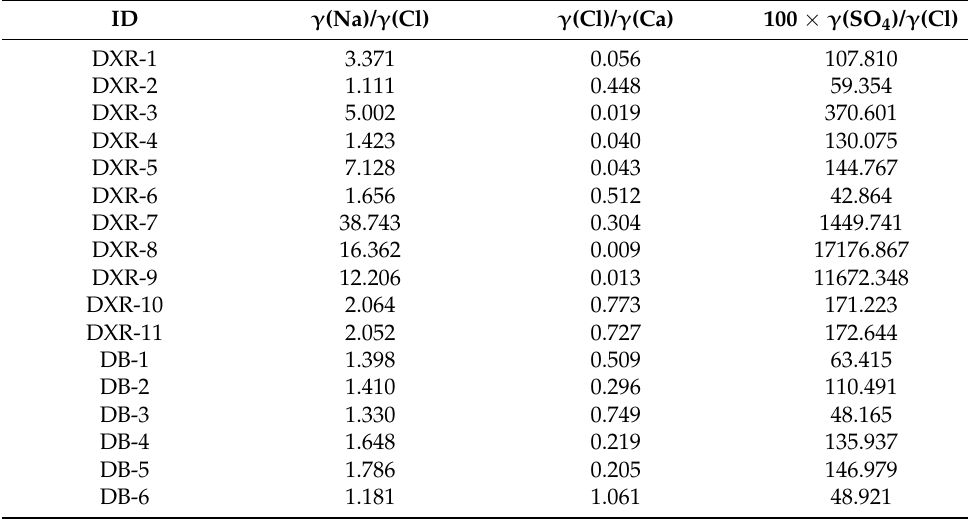
Table 1. Calculation results of geothermal water sample characteristic coefficients.